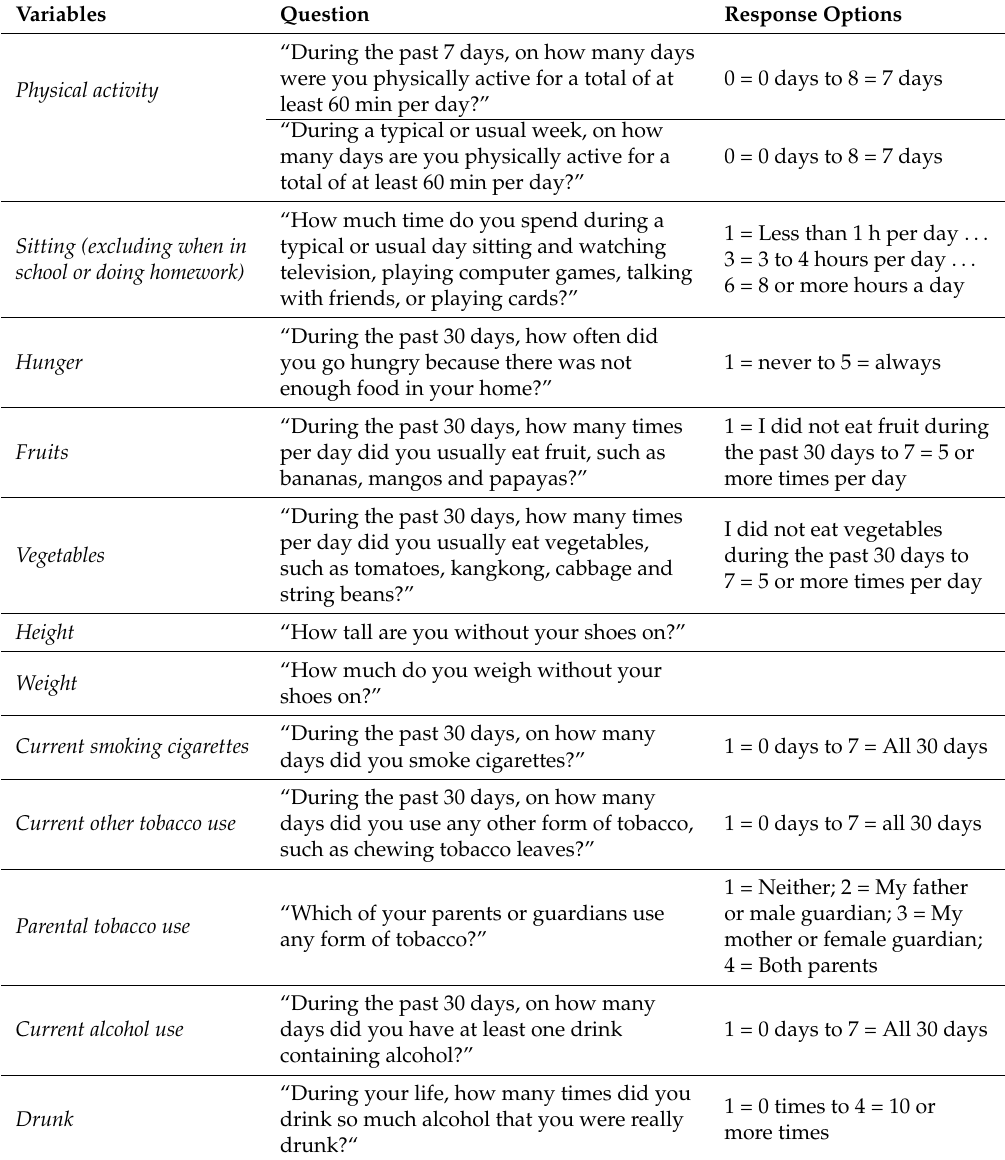
Table A1. Variable